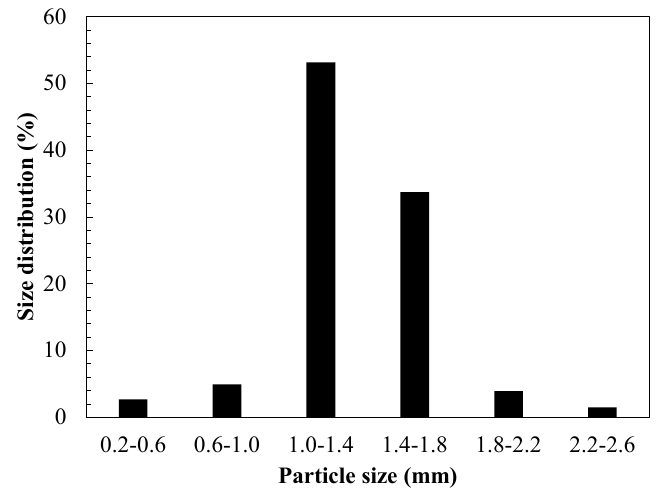
Figure 4. Particle-size distribution of the synthesised MnO 2 /GAC-3 composite.